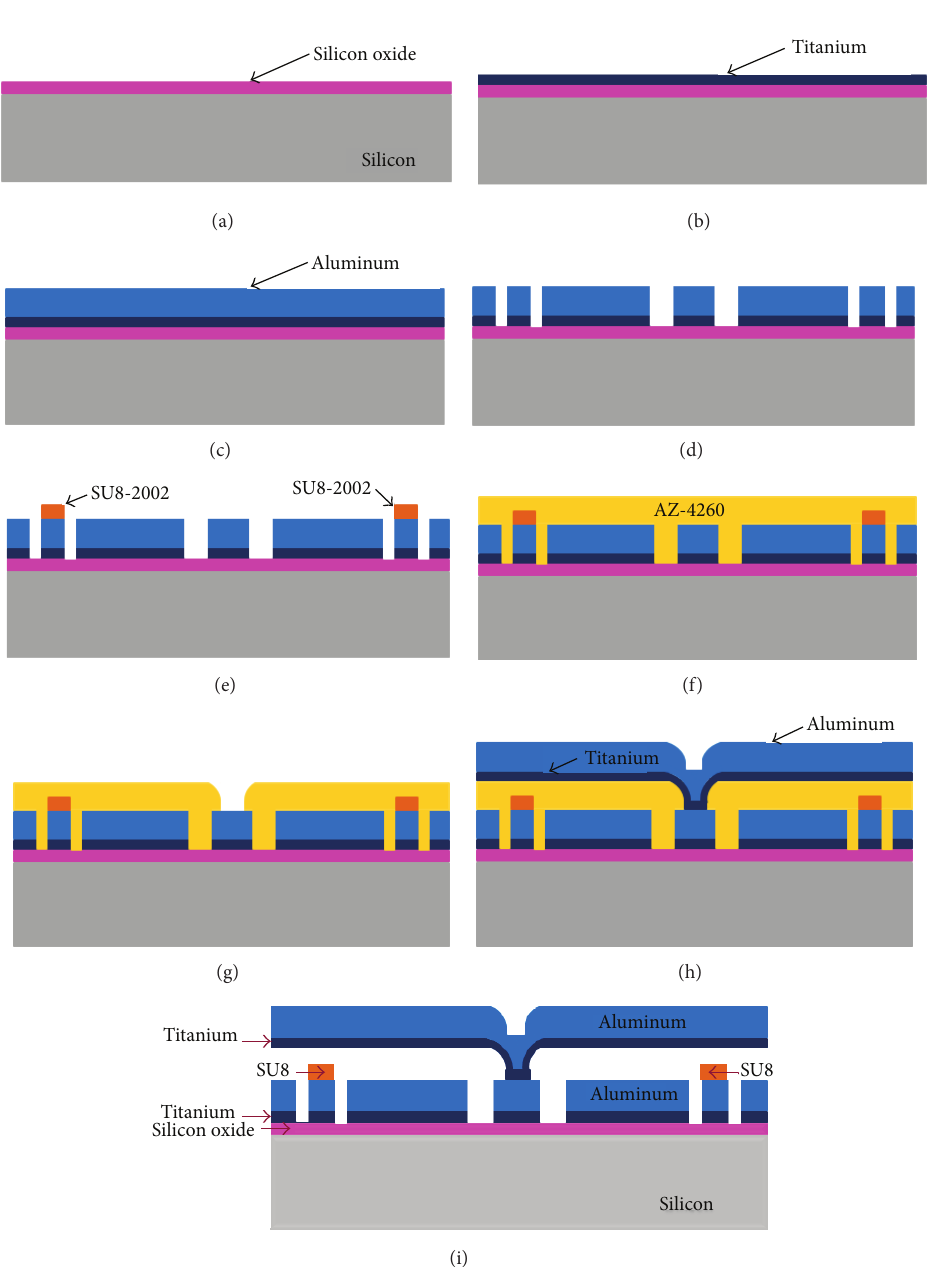
F 8: Fabrication process. (a) Standard wafer cleaning followed by the thermal growth of SiO